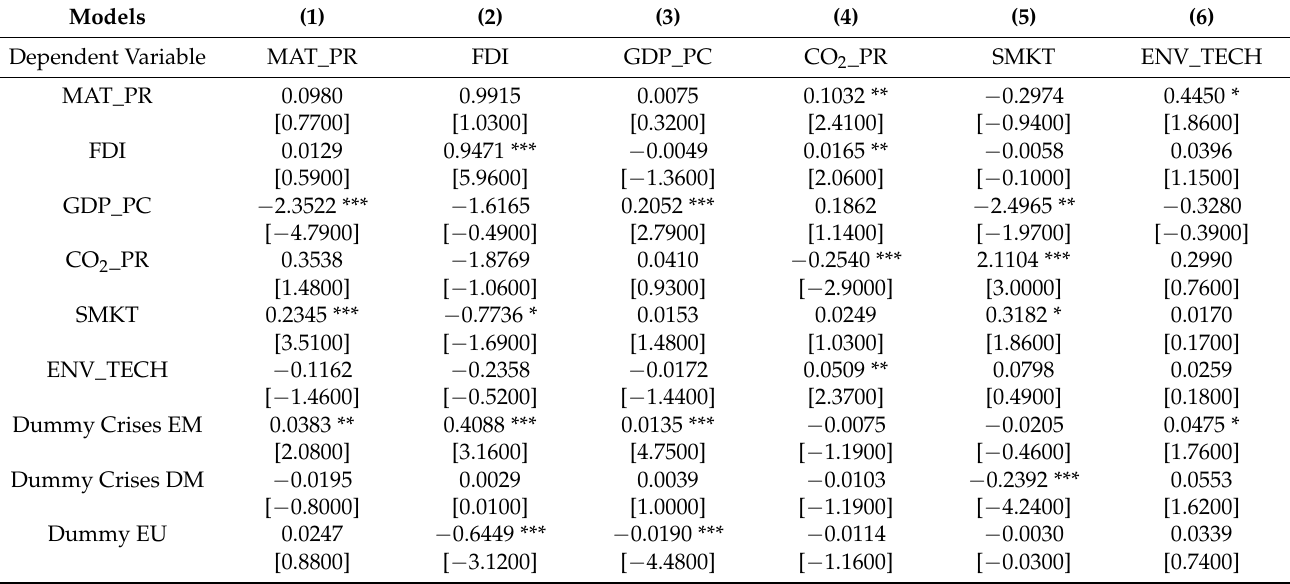
Table 3. The EU-15 Group PVAR